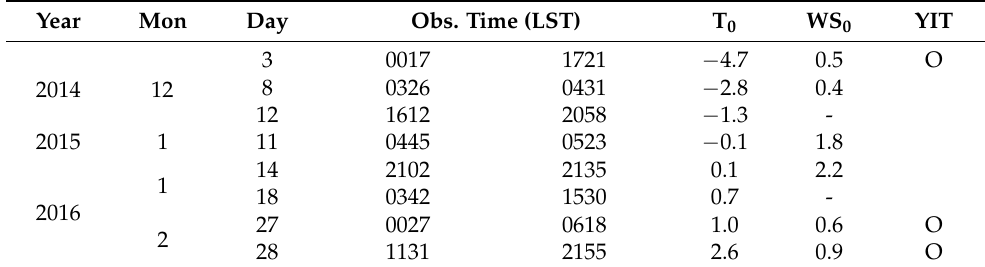
Table 1. Information of the analyzed cases. T 0 and WS 0 denote the averaged T and wind speed (WS) for each analysis period,